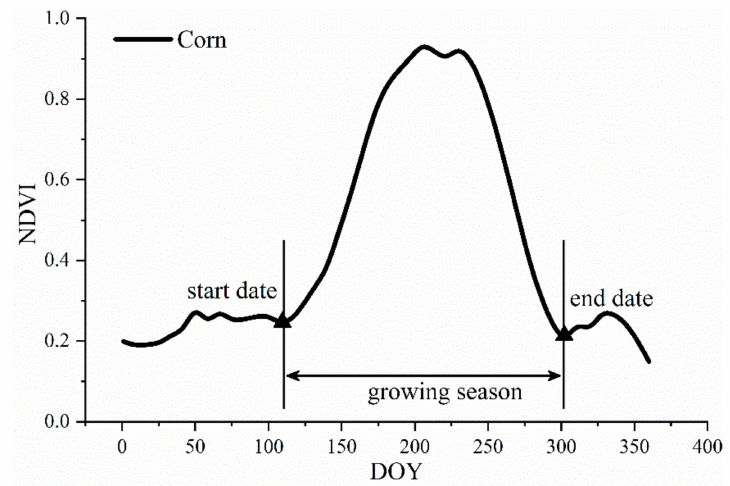
Figure 3. Schematic on how to determine the growing season at the pixel level. NDVI values were extracted from the start date of the growing season to the end date of the growing season for each corn pixel. The “phenologically adjusted” time series values of each corn pixel started with the start date. DOY denotes Day of